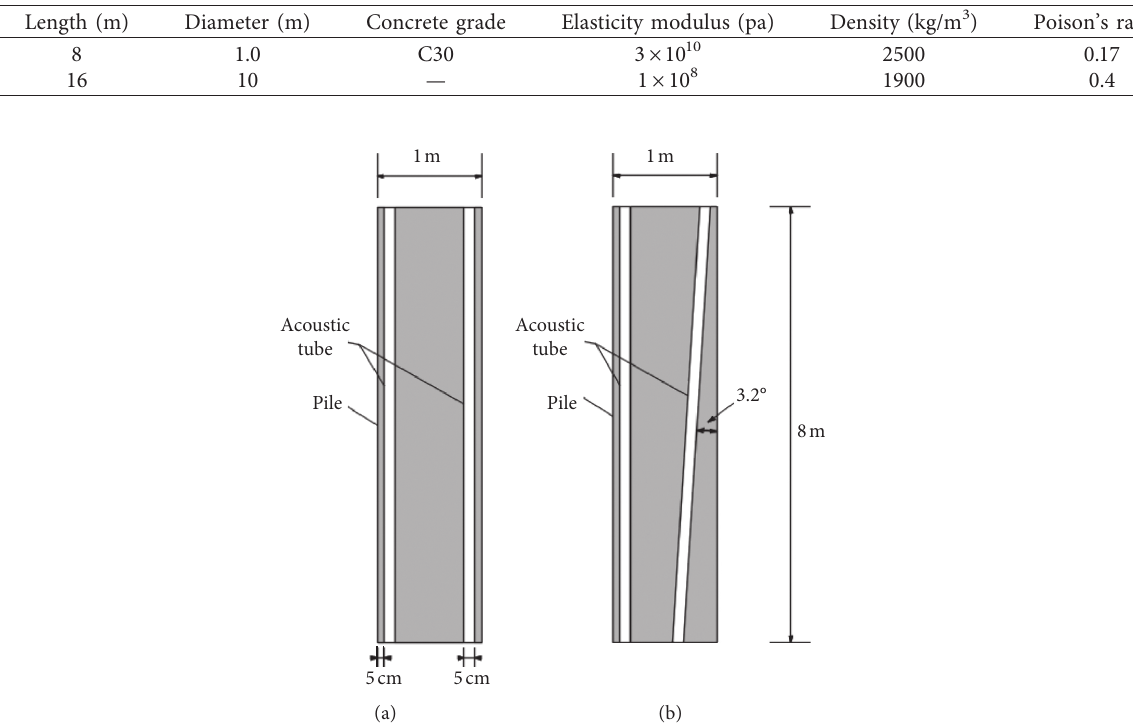
Table 1: Physical and mechanical parameter of the pile and soil.